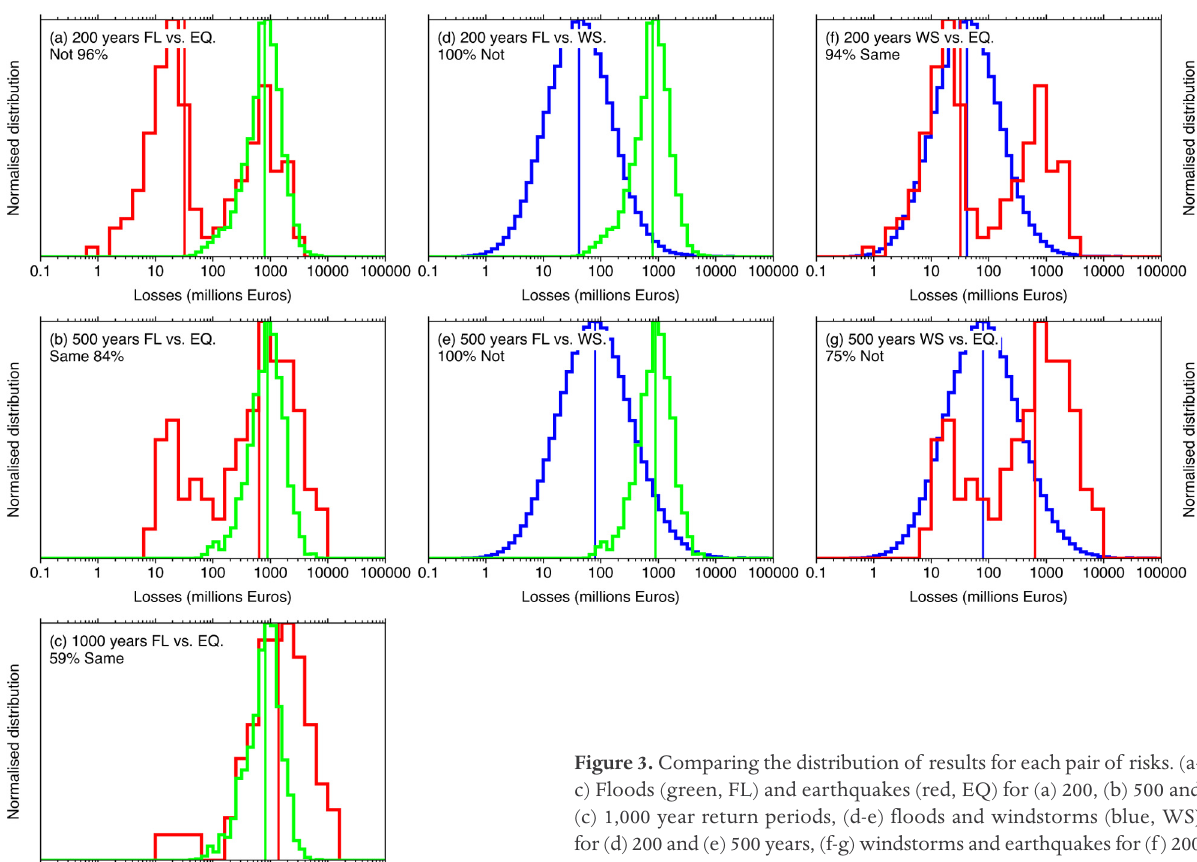
Figure 3. Comparing the distribution of results for each pair of risks. (a- c) Floods (green, FL) and earthquakes (red, EQ) for (a) 200, (b) 500 and (c) 1,000 year return periods, (d-e) floods and windstorms (blue, WS) for (d) 200 and (e) 500 years, (f-g) windstorms and earthquakes for (f) 200 and (g) 500 years. The vertical lines of the same colors are the respec- tive